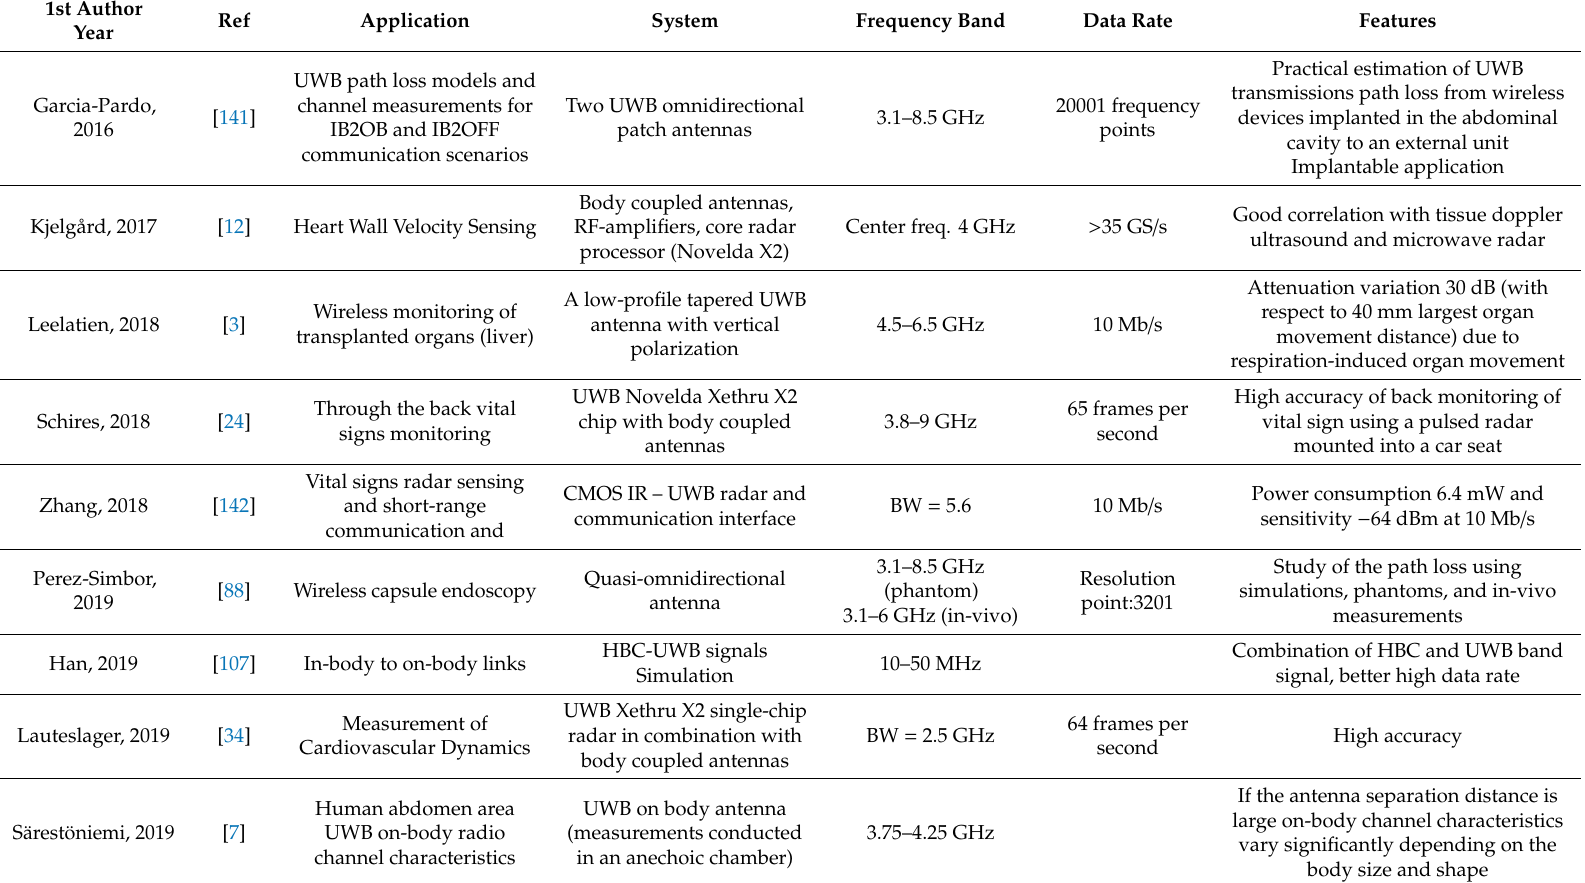
Table 2. Comparison of ultra-wideband communication systems in WBAN reported in